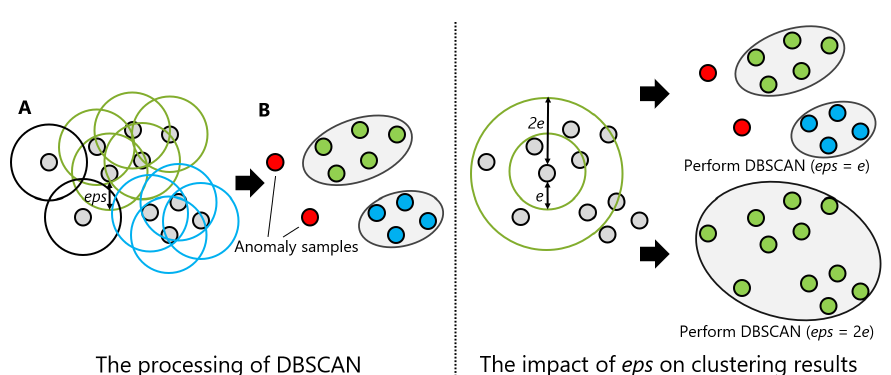
Figure 2. An illustration of density-based spatial clustering of applications with noise (DBSCAN): the left and right parts are the processing of DBSCAN and the impact of Eps-neighborhood (eps) on the clustering results, respectively.